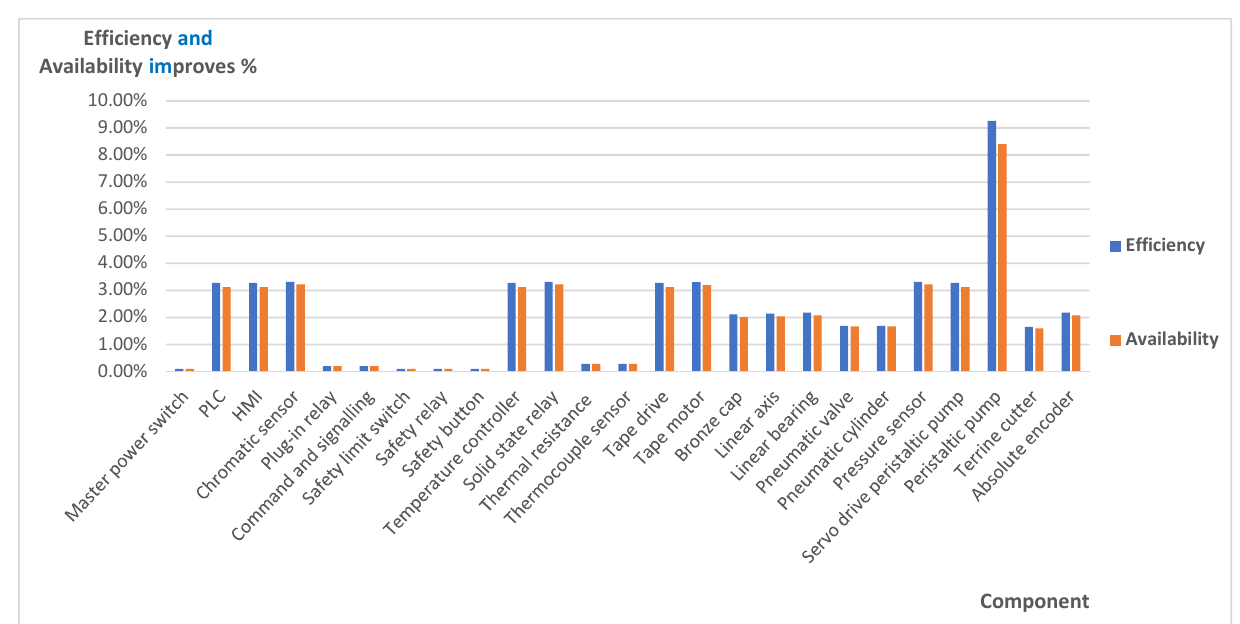
Figure 5. Percentage of improvement in efficiency and availability using IPPM strategy in terms of PPM.